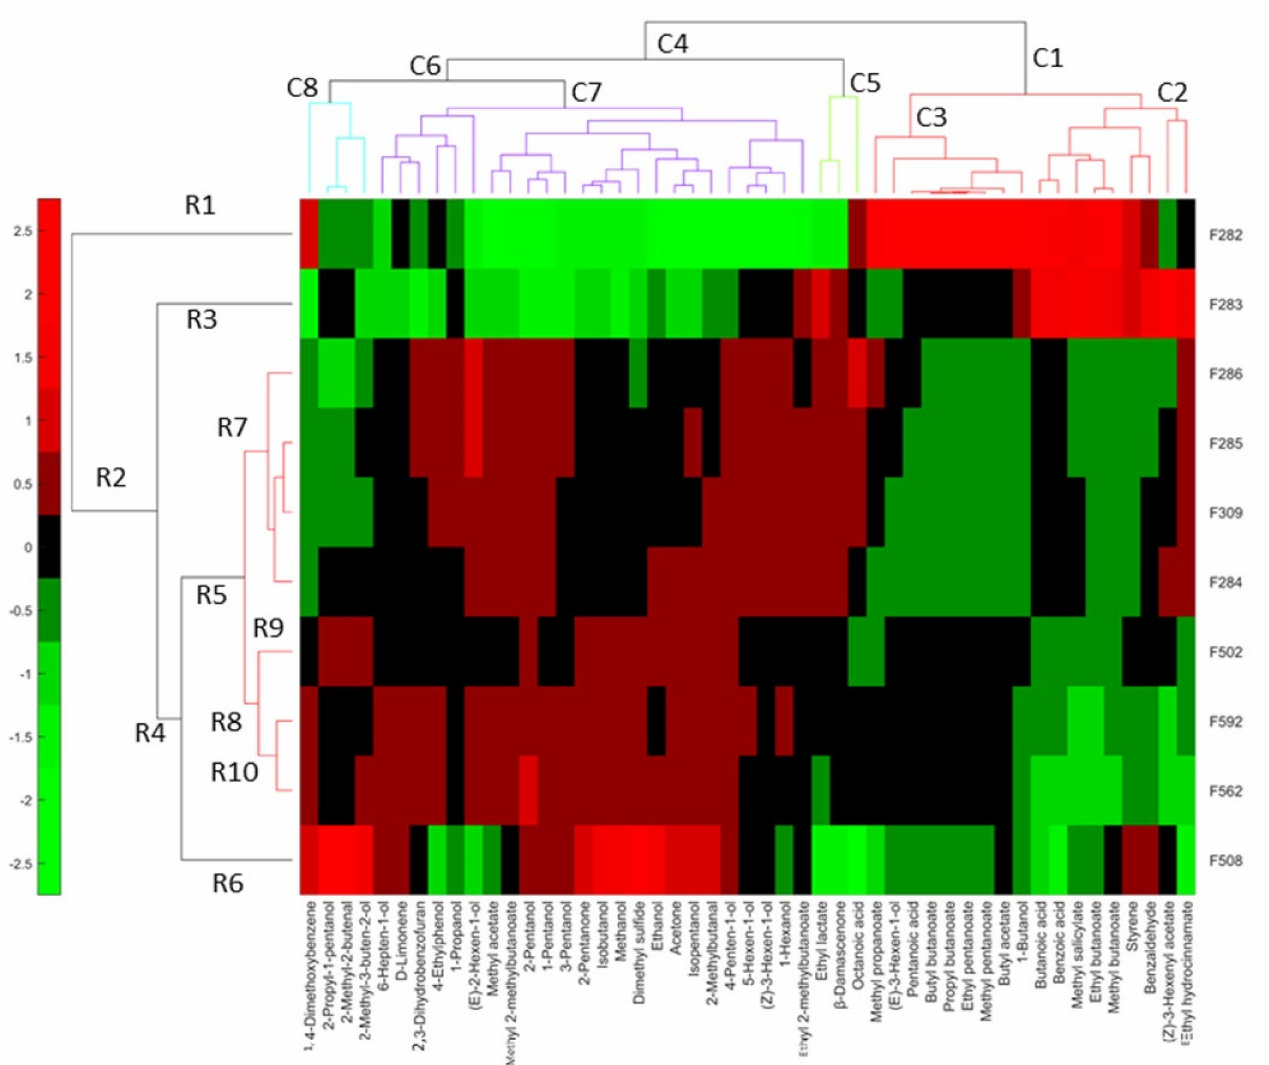
Figure 10. Heatmap based on only those VOCs associated with spoilages by at least one previous statistical technique. Symbols of samples correspond to industry A (F282 and F283, affected by butyric spoilage; F284, F285, F286, F309, normal fermentation) and industry B (F508 and F562, sulfidic and putrid spoilage, respectively; F502 and F592, normal